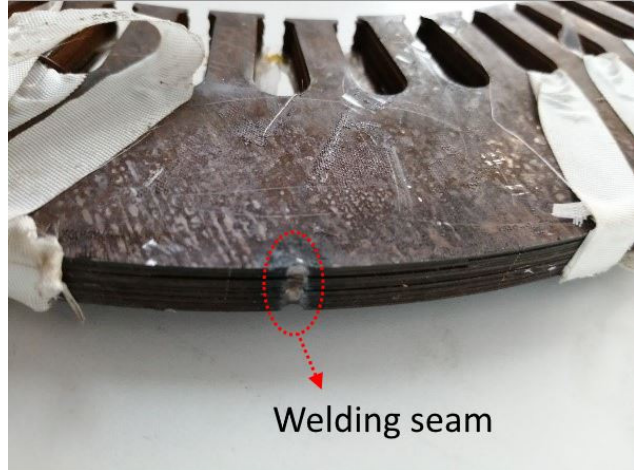
Figure 1. Welding seam on outer edge of stator laminations.